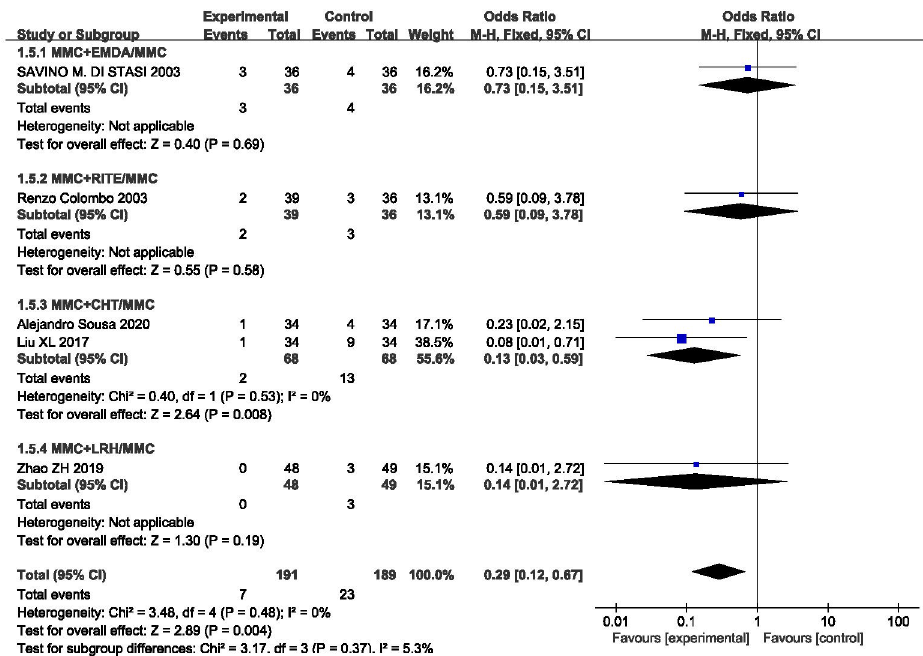
Fig 5. Forest plots for the meta-analysis of the progression rates by the different equipment.